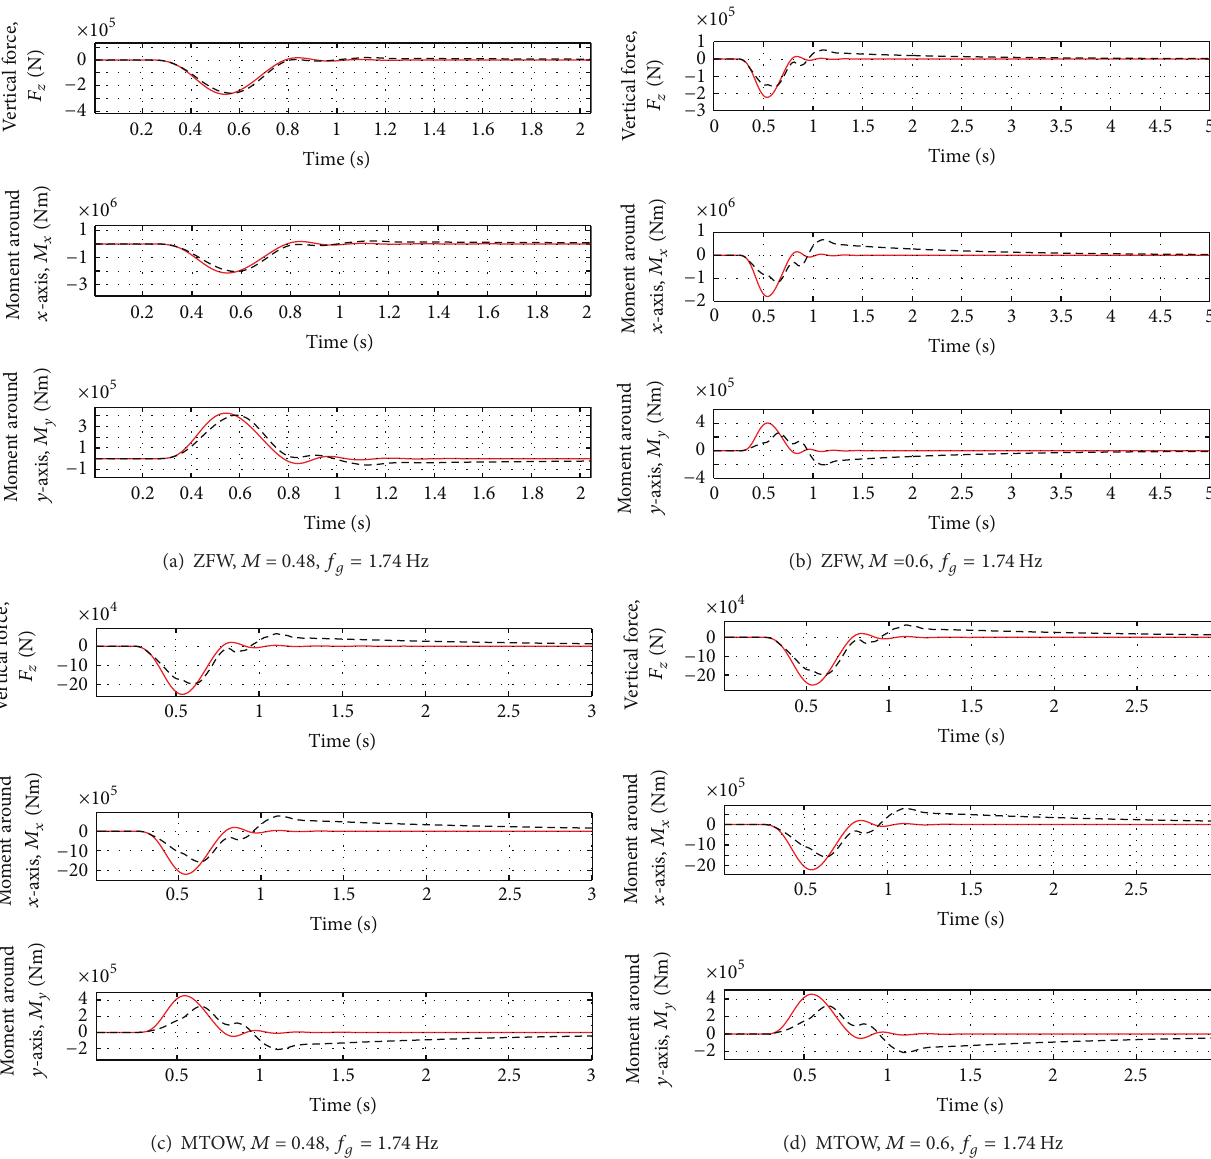
Figure 11: Wing loads for all the cases in Table 5. Red solid line: open loop. Black dotted line: closed